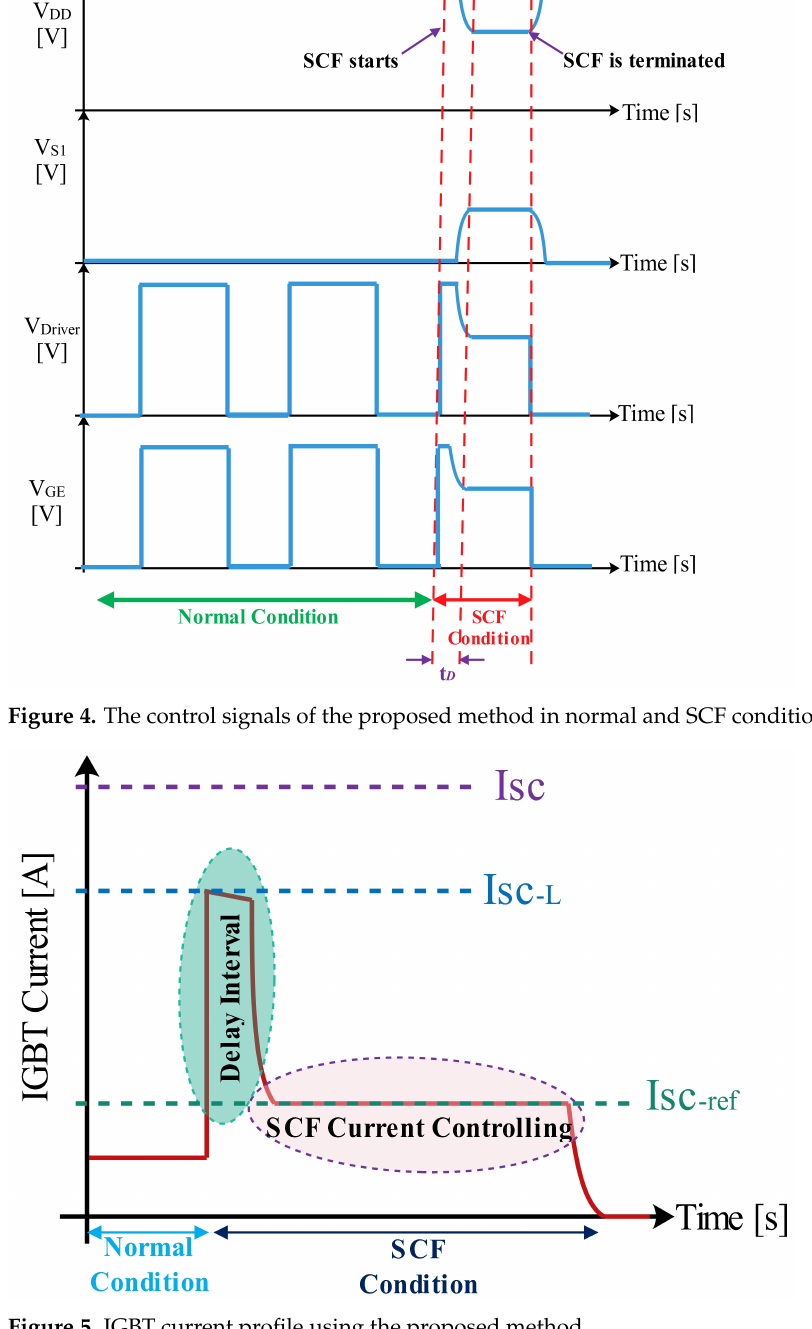
Figure 5. IGBT current profile using the proposed